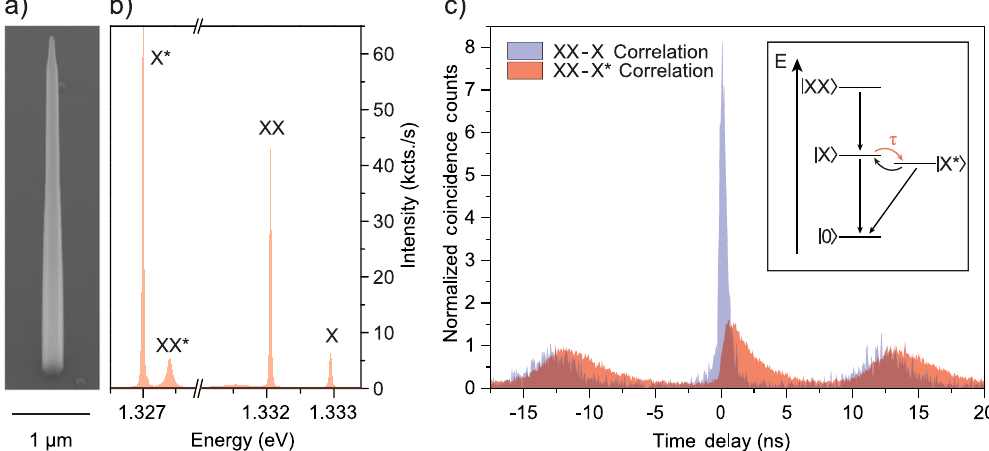
Figure 1. ( a ) SEM image of a pure wurtzite InP nanowire waveguide, containing a single InAsP quantum dot near the base. The tapering of the nanowire waveguide shell allows for efficient light extraction. ( b ) Quantum dot spectrum of the s-shell transitions. ( c ) Cross-correlation measurements of biexciton (XX)–exciton (X) cascade (blue) and biexciton–charged exciton (X * ) cascade (red). The cross-correlation histograms are composed of 64 ps time bins. A fast exciton decay with T = 0.41 ± 0.08 ns starts after the biexciton trigger. The observed delay of the charged exciton emission after the biexciton trigger is attributed to the charging time τ = 0.39 ± 0.08 ns of the quantum dot. The inset schematically shows the charging effect and the two possible competing recombination